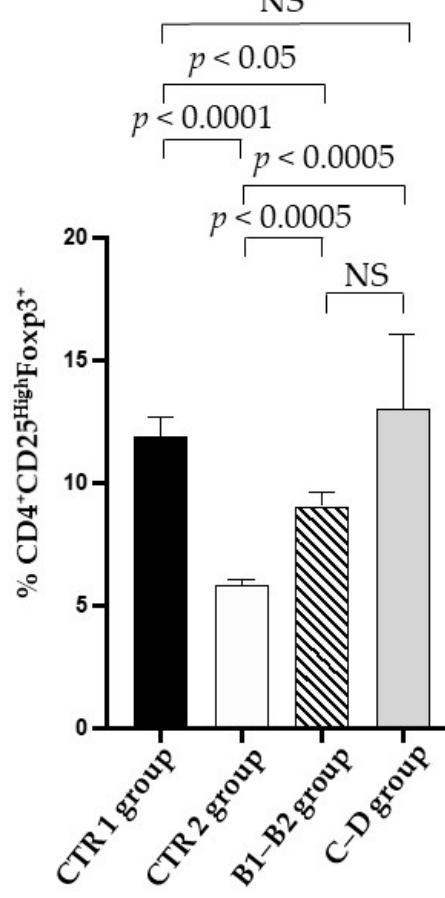
Figure 4. Treg cells in enrolled dogs. Treg percentage (CD4+ CD25 high FoxP3 + T cells on y axis) in the healthy young (CTR 1) group (black column), the healthy elderly (CTR 2) group (white column), the mild and moderate MMVD (B1–B2) group (dashed column), and the severe and very serious MMVD (C–D) group (grey column). A Mann–Whitney matched-pairs signed-rank test was performed to compare the different groups. NS means “no significant